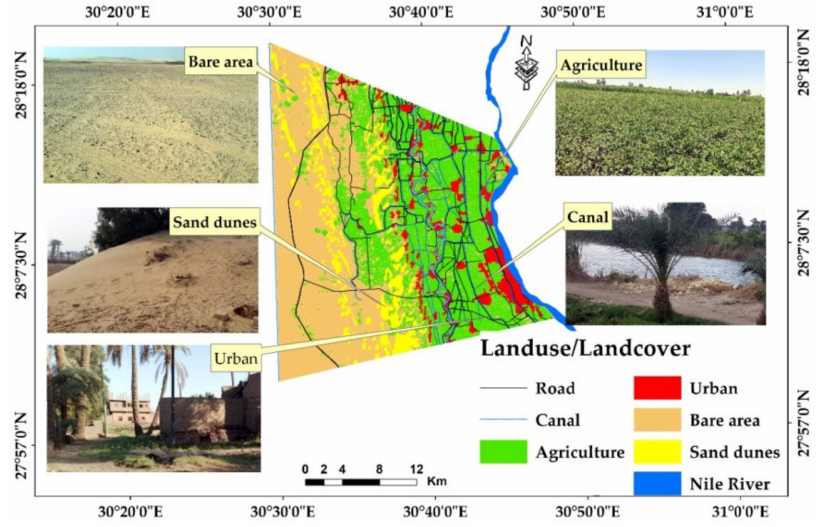
Figure 5. Land use and land cover of experimental area. Table 1. Error of omission, kappa coefficient, and accuracy evaluation for the LU/LC of the study area based on SA and Landsat OLI